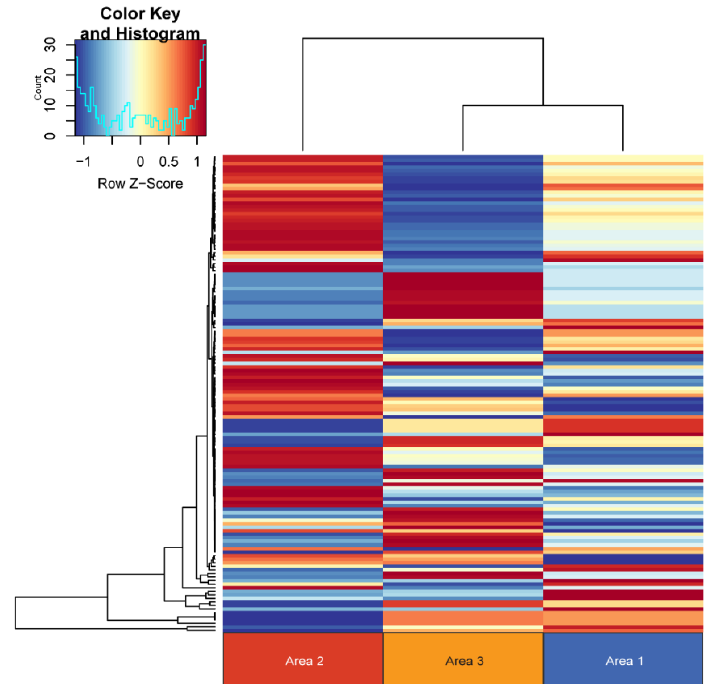
Figure 4. RNA-Seq Heatmap. Normalized read counts by counts per million (CPM) in differentially expressed genes are depicted here. Distinct gene expression profiles can be appreciated in each biopsied area. Each column is depicted as list of genes.